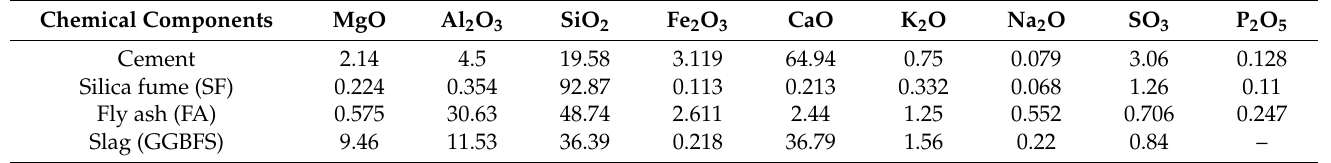
Table 1. Chemical components of cement, silica fume, fly ash, and slag